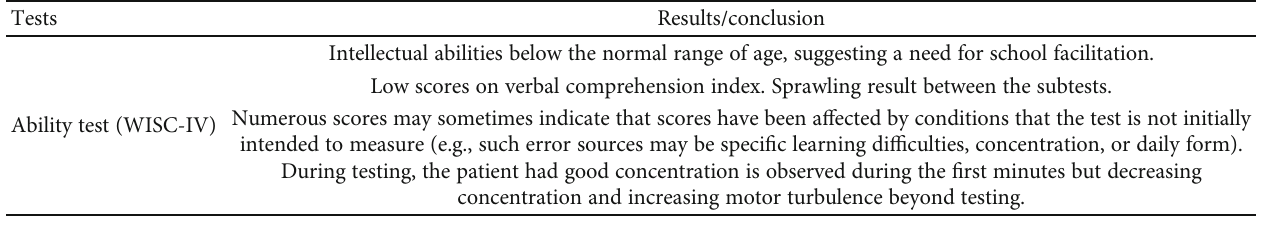
Table 1: Summary of the psychological